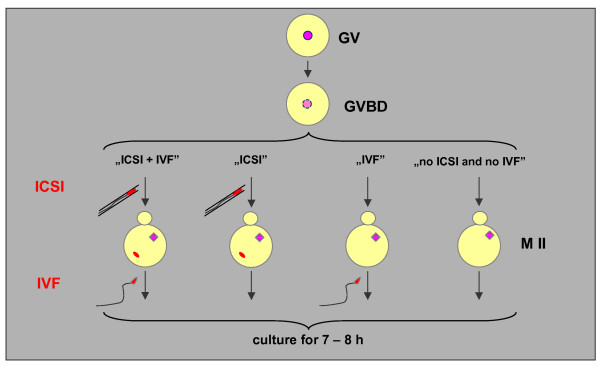
Design of the experiment (see description in text).